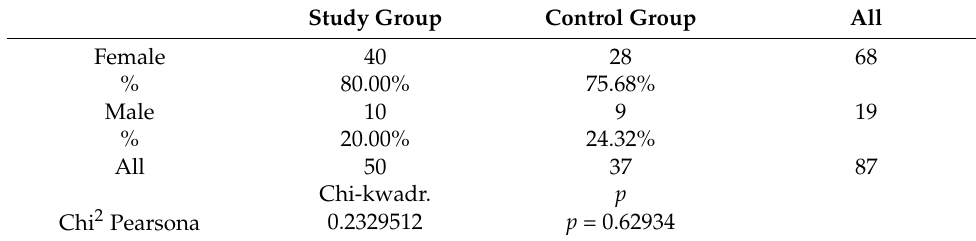
Table 2. Gender differences between